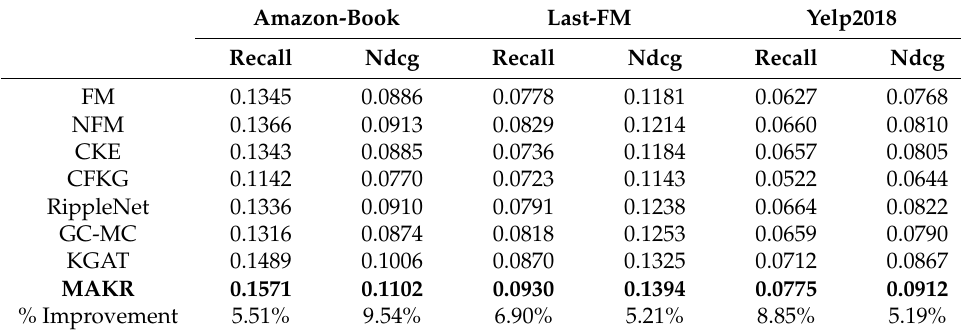
Table 2. Overall performance